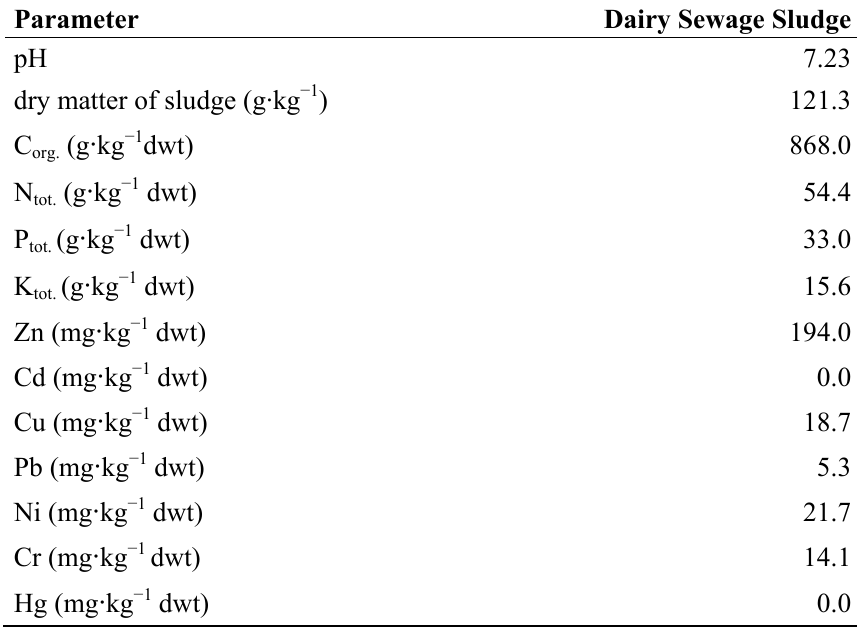
Table 2. Characteristics of the dairy sewage sludge used in the